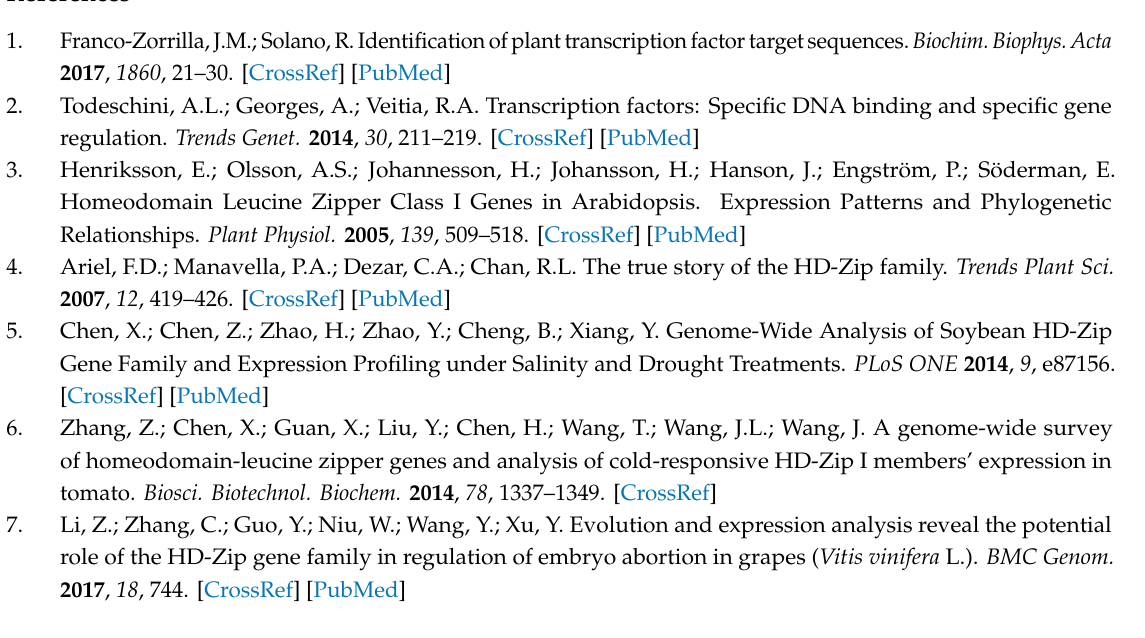
Figure S1: Multiple sequence alignments in NtHD-Zip I proteins, Figure S2: Sequence logos of NtHDZI motifs in N. tabacum. The overall height of the stack represents the level of sequence conservation. The height of the residue in the stack represents the relative frequency of each residue at that location, Figure S3: The distribution of di ff erent stress-related cis-elements predicted in the promoter region of NtHD-Zip I genes, Figure S4: Promoter Analysis of HD-ZIP I genes in tobacco. A sequence of 2000 bp upstream of the start codon ATG of HD-Zip I genes in N. tabacum were investigated to analyze cis-elements by using Genomatix. Putative cis-elements were represented by di ff erent colors and distributed on the black lines, Table S1: Protein sequences of HD-Zip I in Nicotiana tabacum, Camellia sinensis, Solanum lycopersicum, Oryza sativa, Manihot esculenta, Zea mays, and Arabidopsis thaliana, Table S2: Primer sequences used for the qPCR analysis of HD-Zip I gene expression in tobacco, Table S3: Distribution of NtHD-ZIP I gene in ancestral species N. sylvestris and N. tomentosiformis, Table S4: Predicted motif sequence in NtHD-Zip I proteins, Table S5: Classification and statistics of di ff erent kinds of cis-acting elements in the promoter regions of NtHDZI